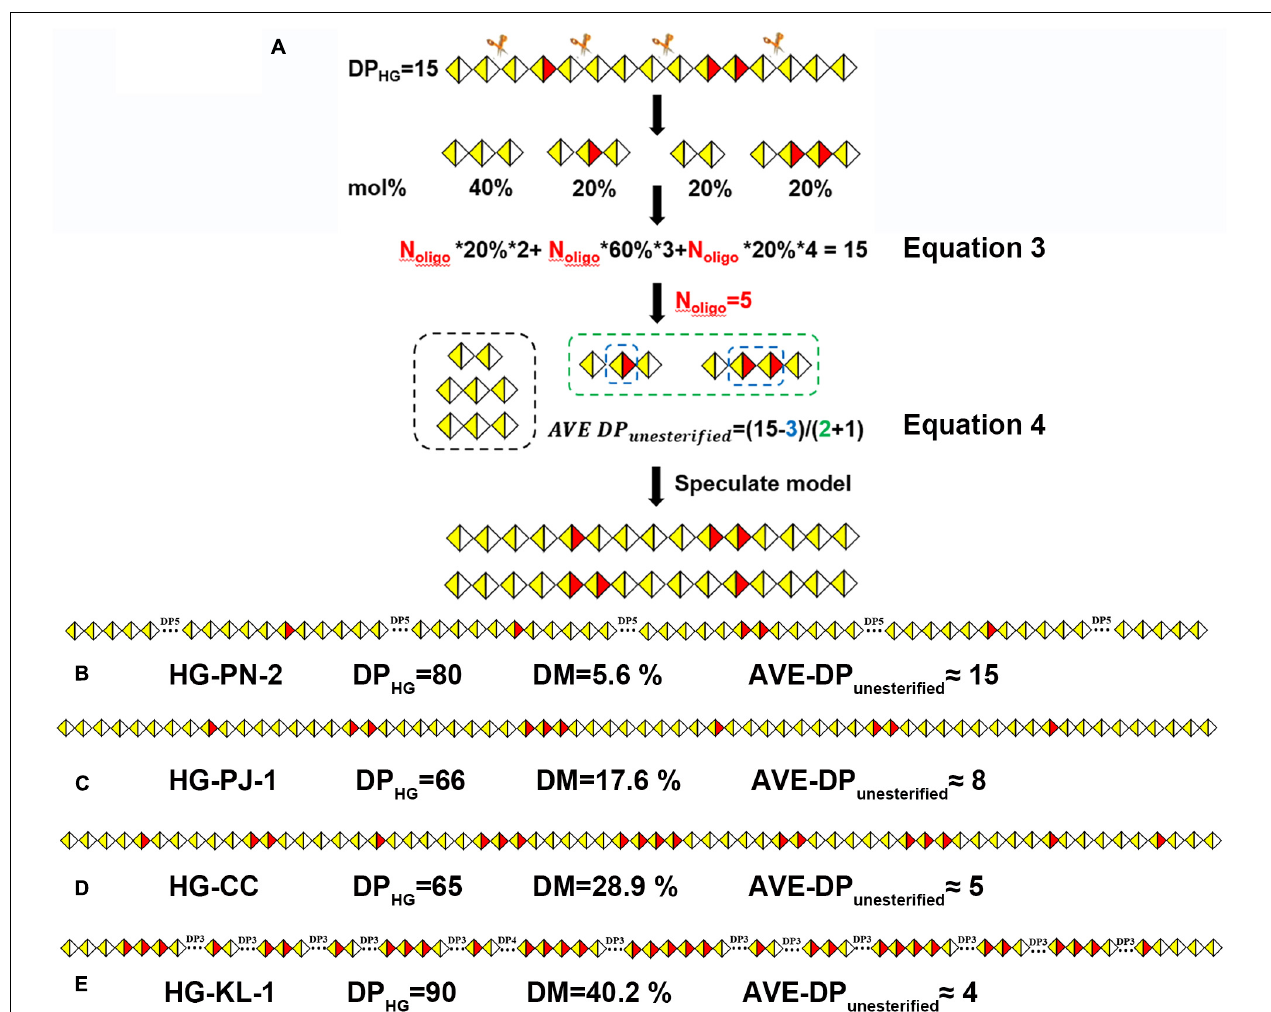
FIGURE 10 | (A) The calculation process of the number of oligogalacturonides ( N oligo ); methyl-esterification distribution models of HG pectins with different DM: (B) HG-PN-2(Class I); (C) HG-PJ-1 (Class II); (D) HG-CC (Class III); (E) HG-KL-1 (Class